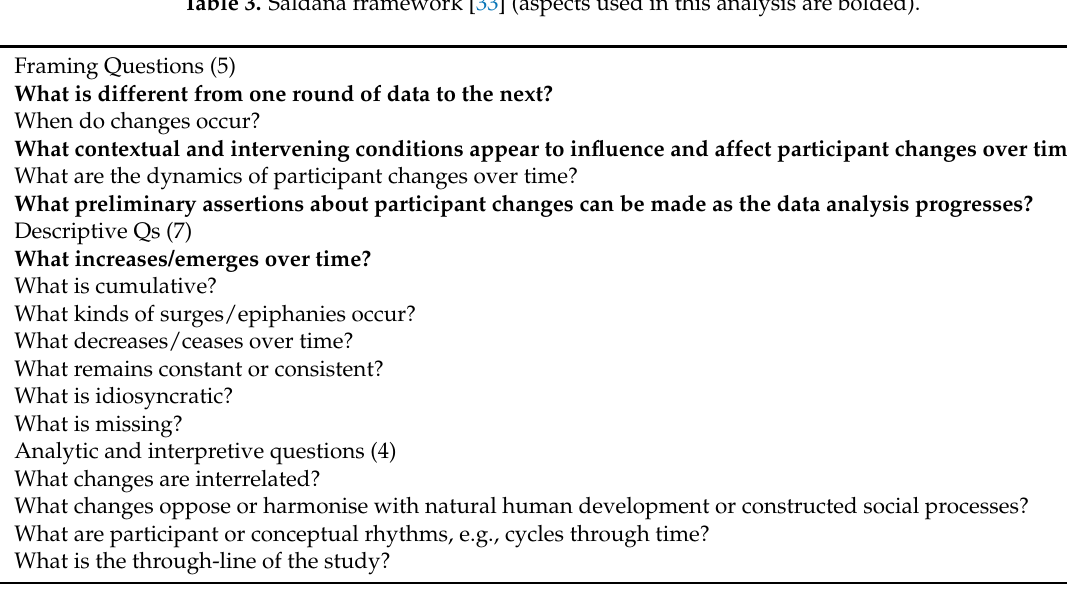
Table 3. Saldaña framework [33] (aspects used in this analysis are